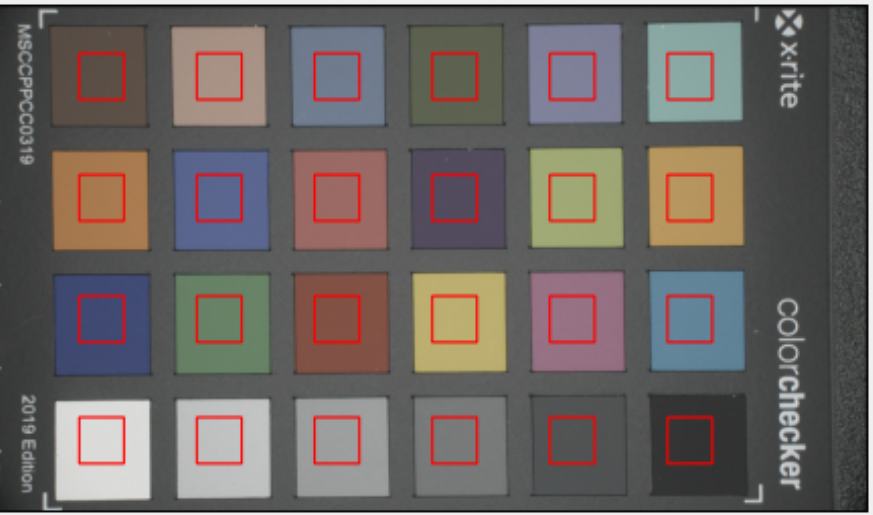
Figure 12. X-rite colour checker chart measured by the camera showing the region of interest areas. A table of colour regions vs. reference sRGB values [43] provides the ground truth for each colour in the